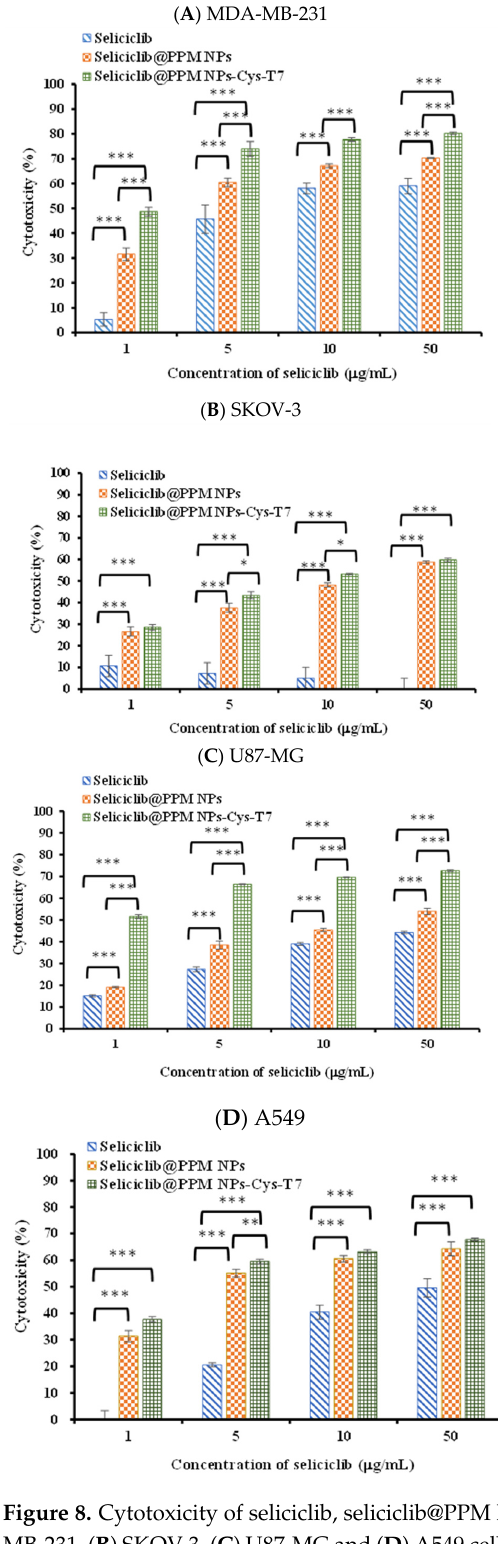
Figure 7. Correlation of TfR expression level and ( A ) internalization of T7 peptide as well as ( B ) cellular uptake of PPM NPs-Cys-T7 in four cancer cell lines.